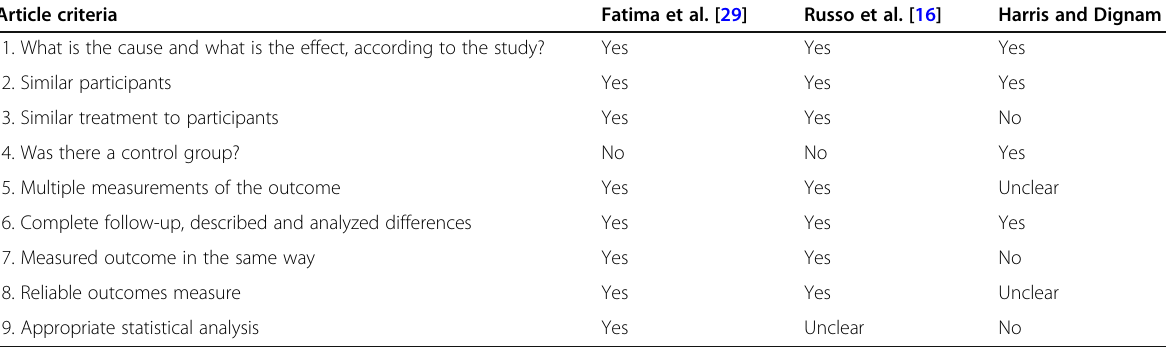
Table 5 critical appraisal for quasi-experimental studies: JBI Article criteria